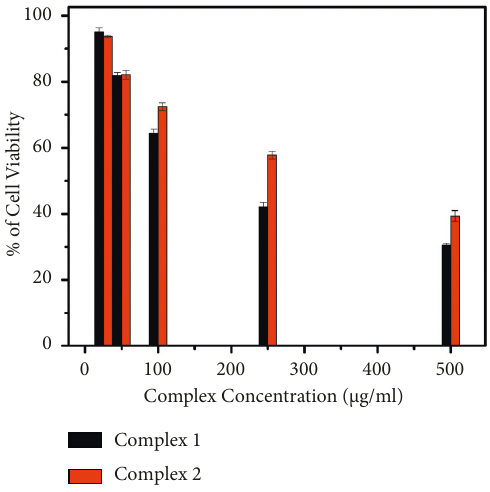
Figure 20: Cell viability of complexes 1 and 2 .